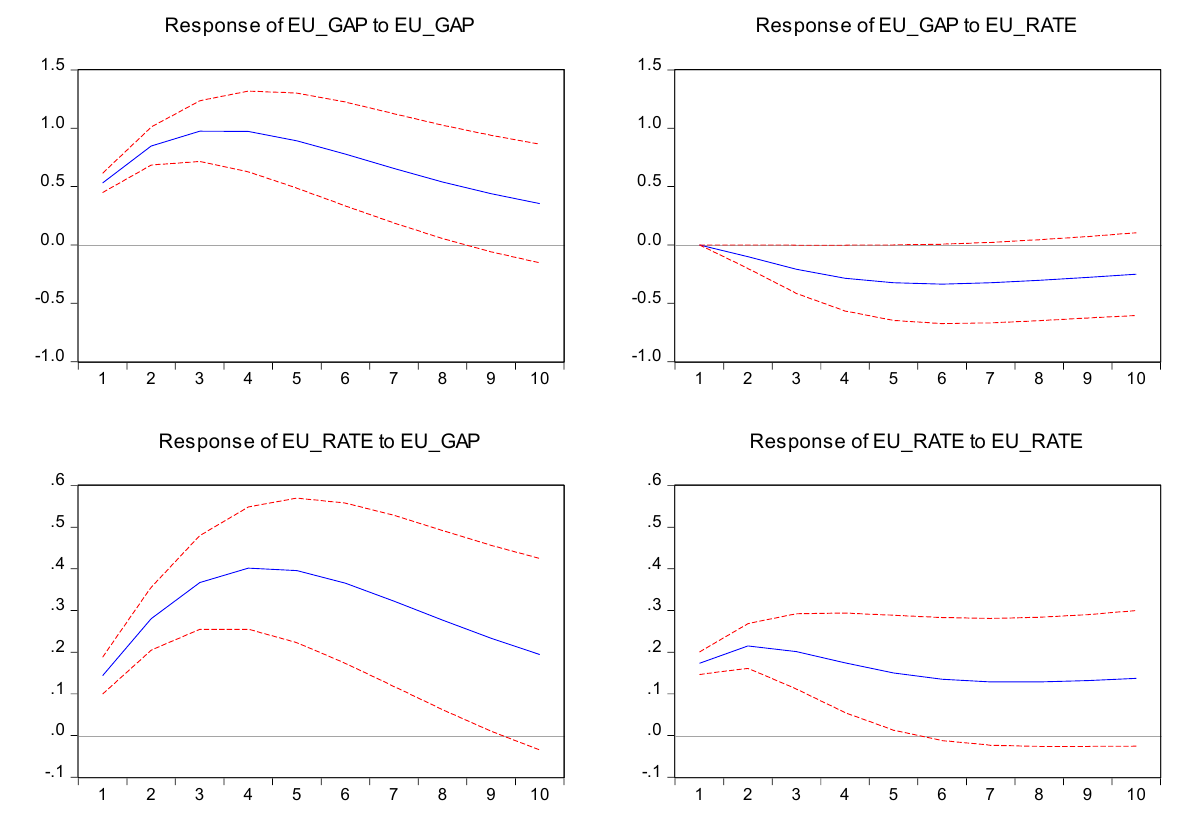
Figure 4. Impulse functions for the